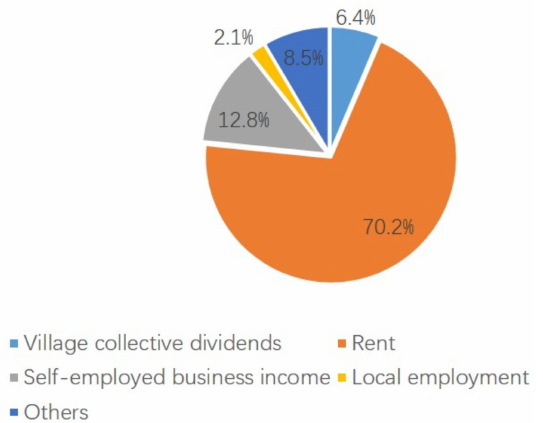
Figure 13. Reasons for the increase in respondents’ household monthly income under the CT practice (YDT) (source: authors).